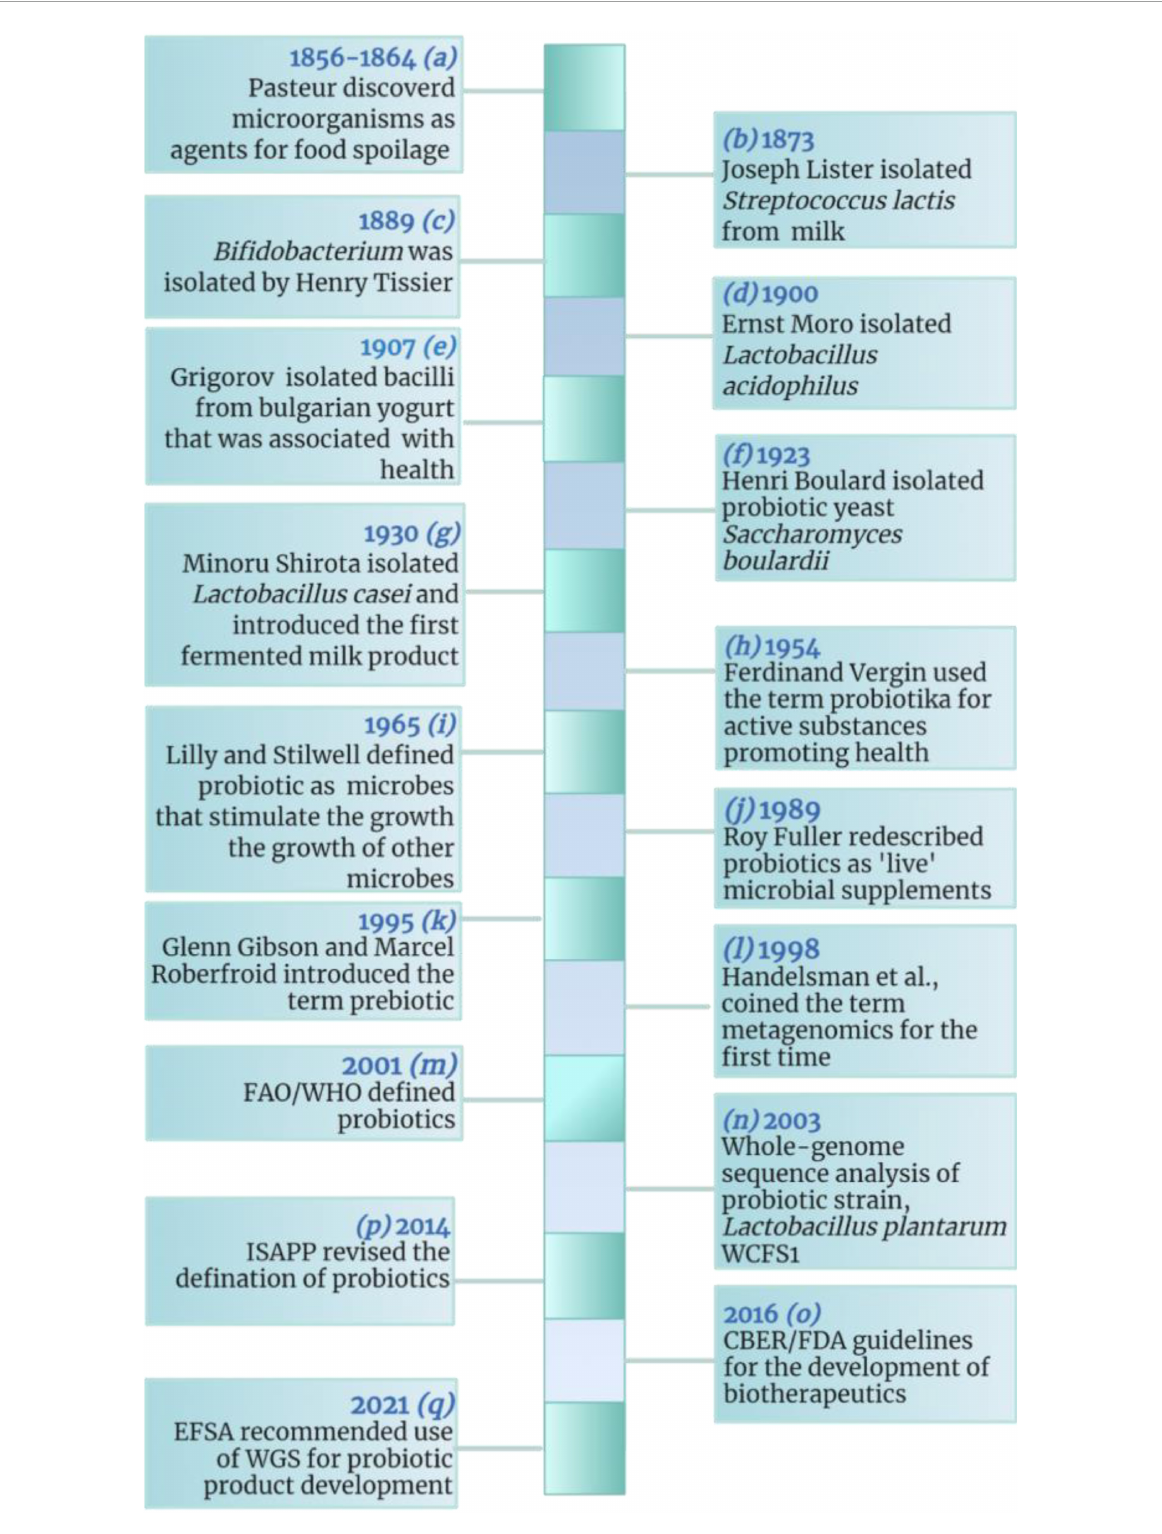
FIGURE1 A brief history of probiotics. CBER, Center for Biologics Evaluation and Research; EFSA, European Food Safety Authority; FAO, Food and Agriculture Organization; FDA, Food and Drug Administration; ISAPP, International Scientific Association for Probiotics and Prebiotics; WHO, World Health Organization. The figure was drawn with